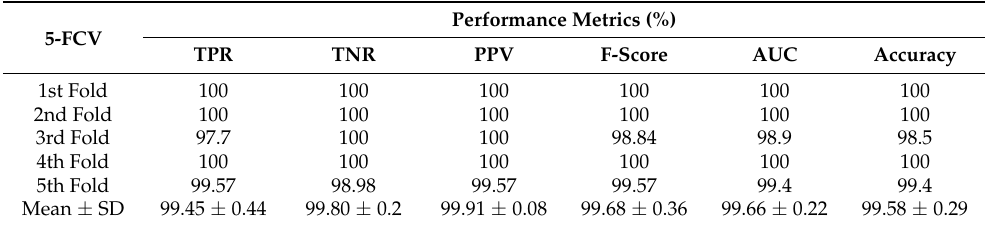
Table 6. Classification performance of the proposed model on Adam optimizer.